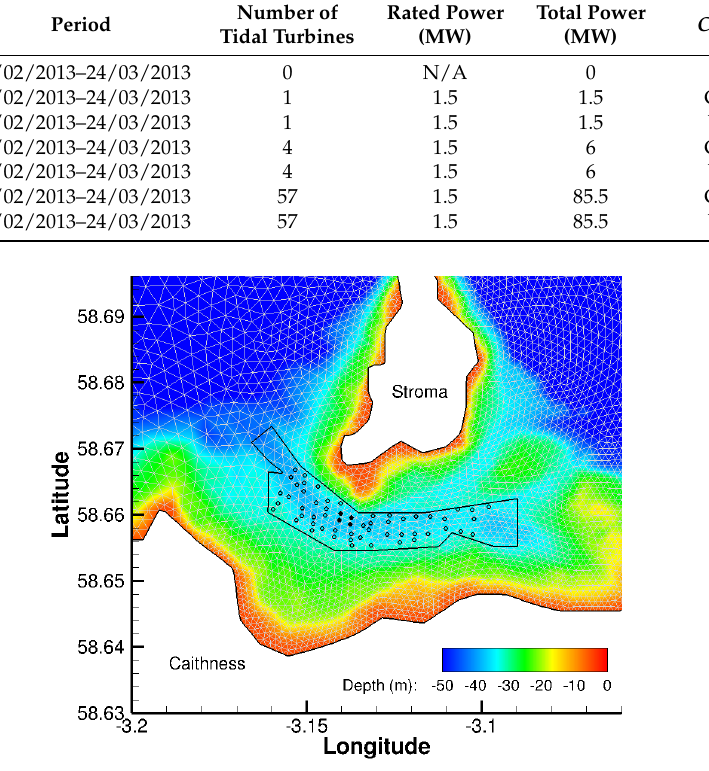
Figure 3. Thrust and power coefficients used in this study as a function of flow speed U (m·s −1 ). ( a ) Thrust coefficient, C T ; ( b ) Power coefficient, C P ; ( c ) Thrust curve (kN); and ( d ) power curve (MW). Table 3. Details of the model simulations performed.